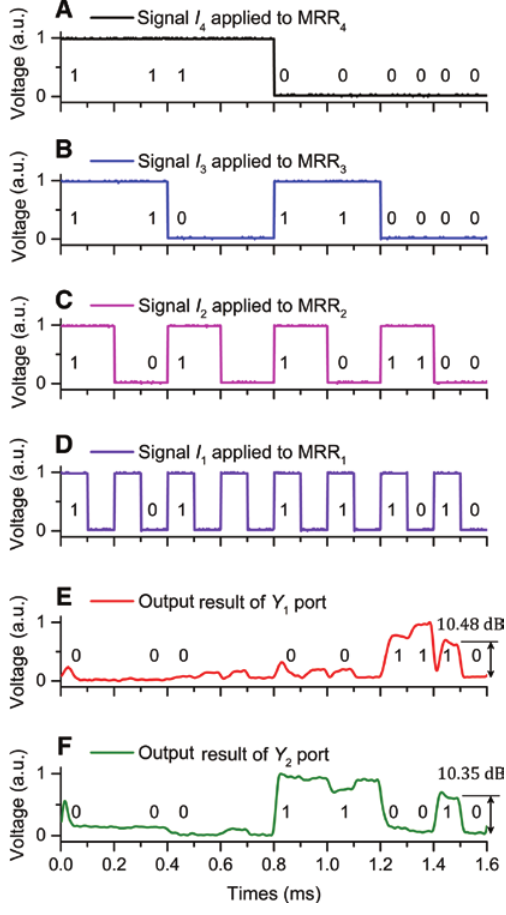
Figure 4: The dynamic performances of the device are measured. (A–D) are signals applied to MRR tively. (E) is the result at the output port Y the output port Y